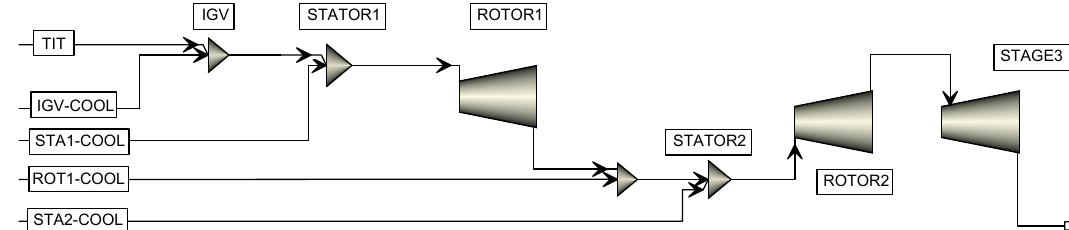
Figure 5. Schematic of the cycle model with the most important components, St_1, R_1 and St_2 refer to the first stator and rotor rows and the second stator row respectively.